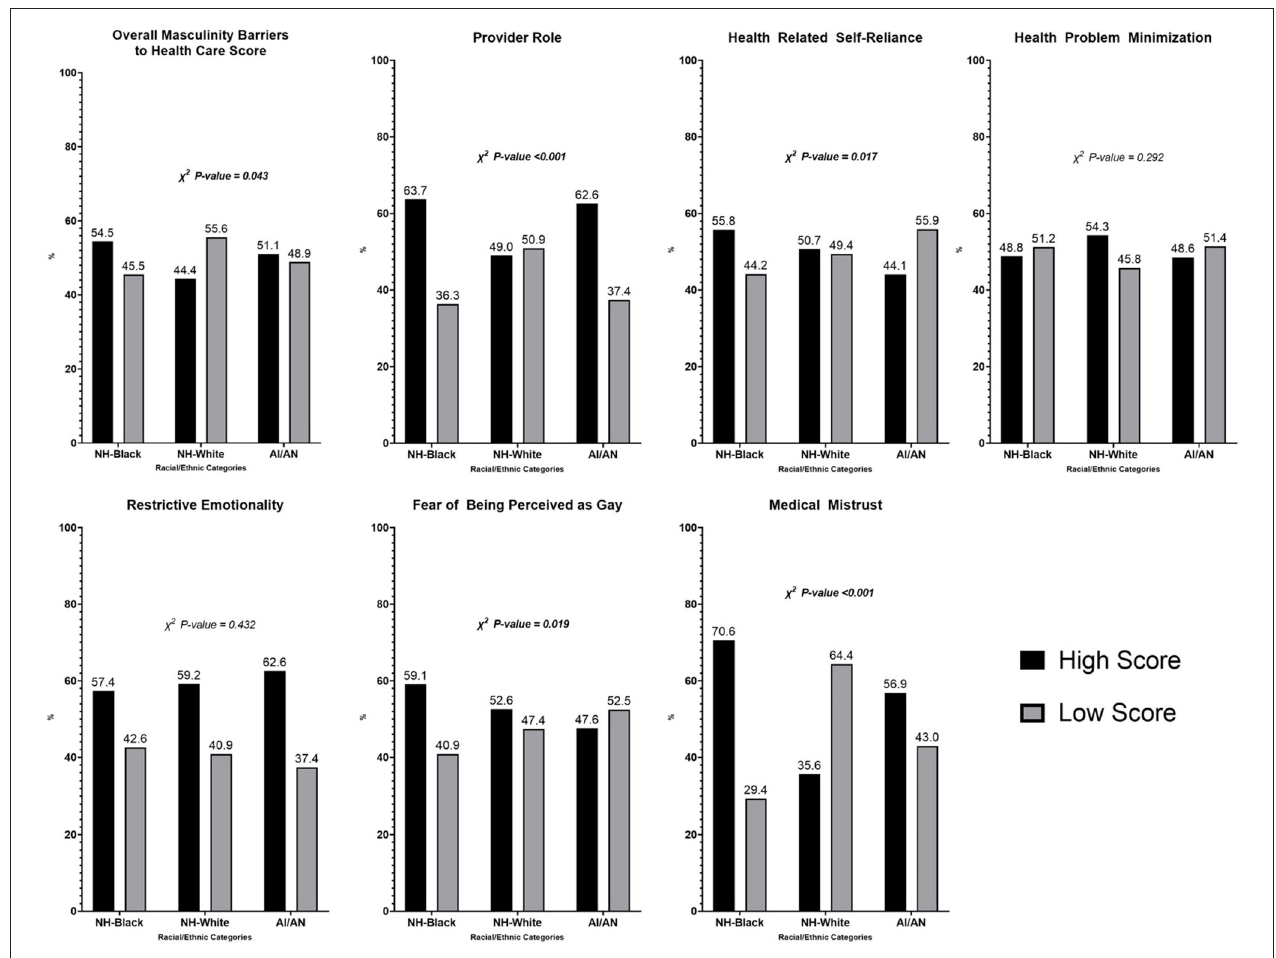
FIGURE 1 | Proportion of high/low scores of overall MBMC and sub-scale specific compared by race/ethnicity. High/low scores defined based on the study population’s median